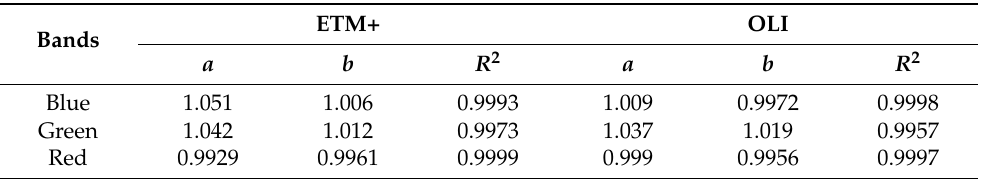
Table 2. The regression results between the bands of Landsat TM with ETM+ and OLI. The a , b are the fitting coefficients, and R 2 is the square of the correlation coefficient. ETM+ OLI Bands a b R 2 a b R